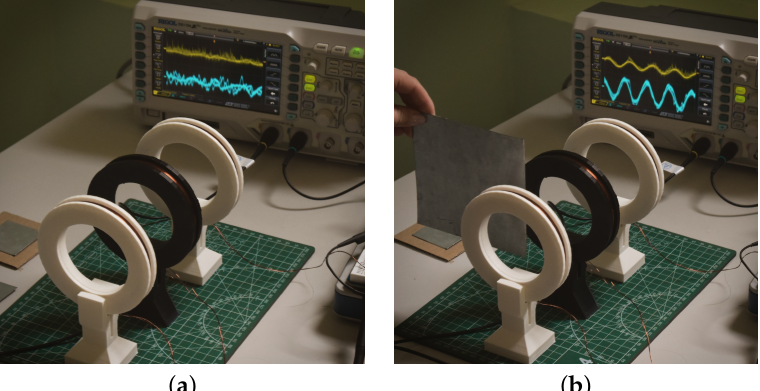
Figure A1. Output of the differential amplifier: ( a ) in the absence of any metal object, and ( b ) in presence of a steel plate put between transmitting (black) and one of the receiving (white) coils. The yellow line is the instrumental amplifier output, and the blue line is the output of the filter. The last signal is used to drive the Duffing oscillator.